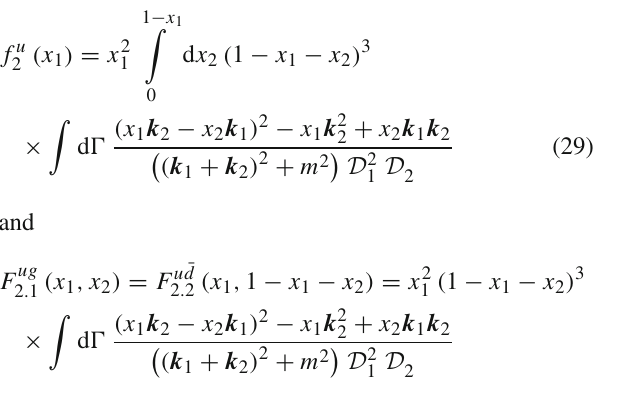
Fig. 5 DPD graphs corresponding to the PDF graph in